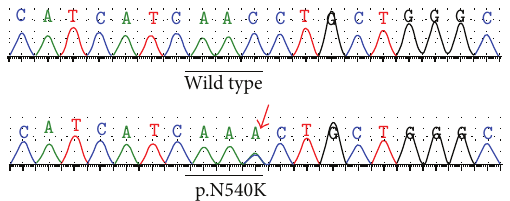
Figure 4: Electropherogram showing the heterozygous base change from cytosine to adenine (arrow) in the FGFR3 gene, which leads to the substitution of asparagine (N) to lysine (K) at codon 540 of the FGFR3